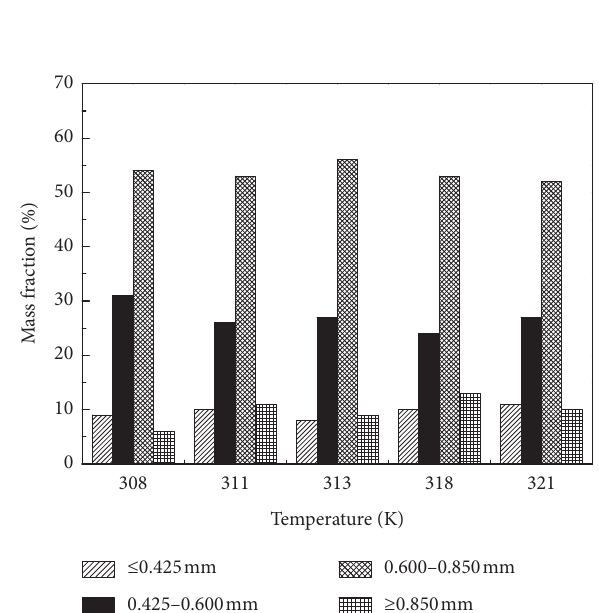
Figure 10: Effect of different temperatures on crystal size